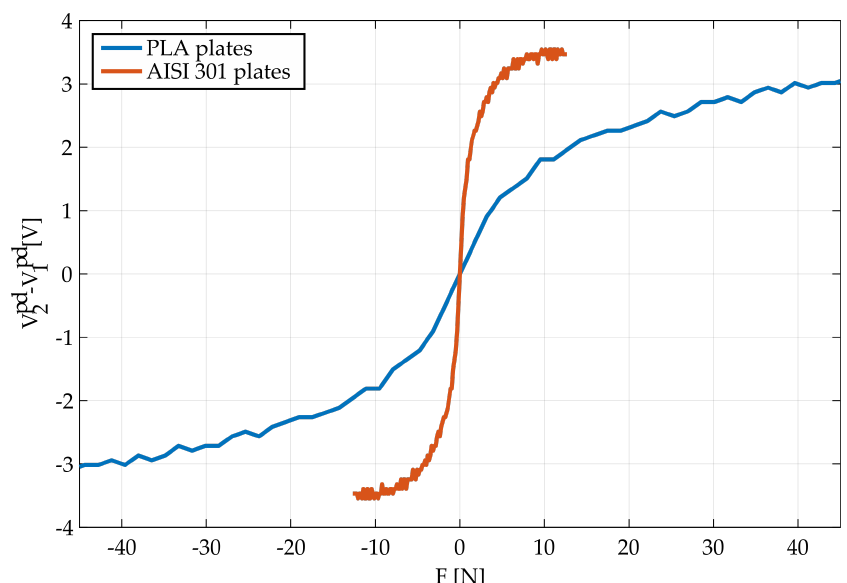
Figure 5. Computed response for the implemented sensor according to the kind of elastic plates used. Signals present a slight ripple due to the discrete nature of the ray tracing simulation.